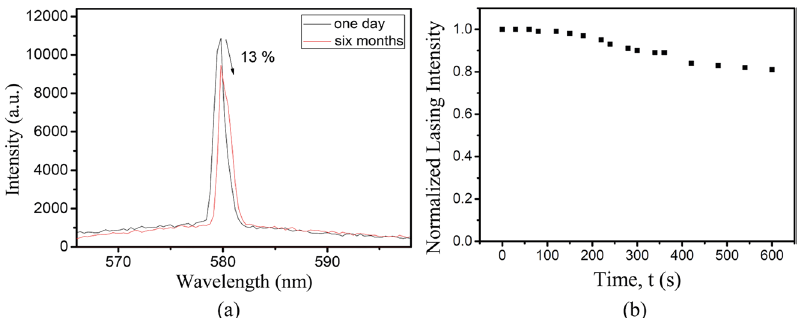
Figure 20: (a) Lasing spectra of the AIPQD − CLC (cell 1) at E = 0.6 μ J/pulse after 1 day and 6 months of storage (black and red peaks, respectively) under room temperature (23 ° C) and high humidity of 60% ( ± 5%). (b) Variation of the measured lasing intensity of the AIPQD − CLC device under continuing excitation of the pumped pulses for 10 min. The measurement was performed under room temperature (23 ° C) and high humidity of 60% ( ± 5%)